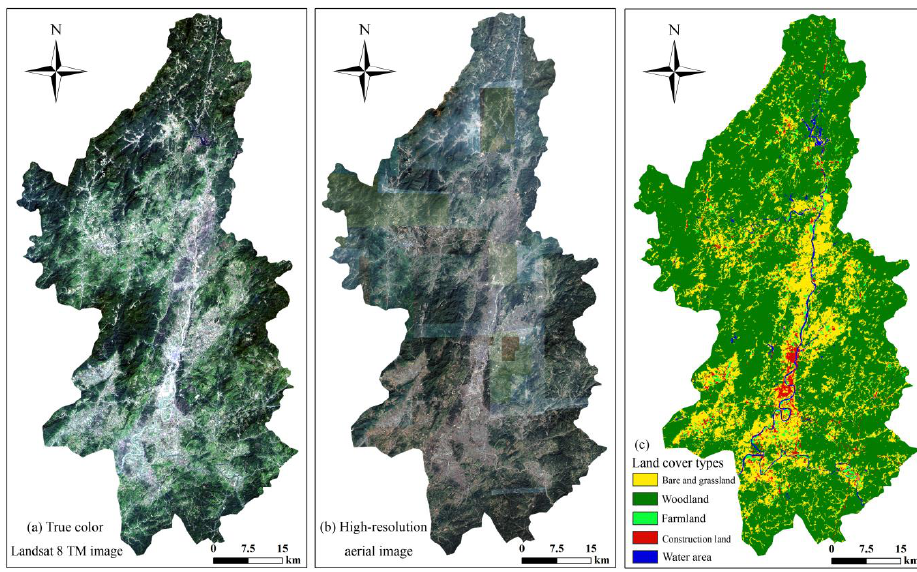
Figure 2. Landsat 8 TM image ( a ), aerial image ( b ), and produced land cover types map ( c ).